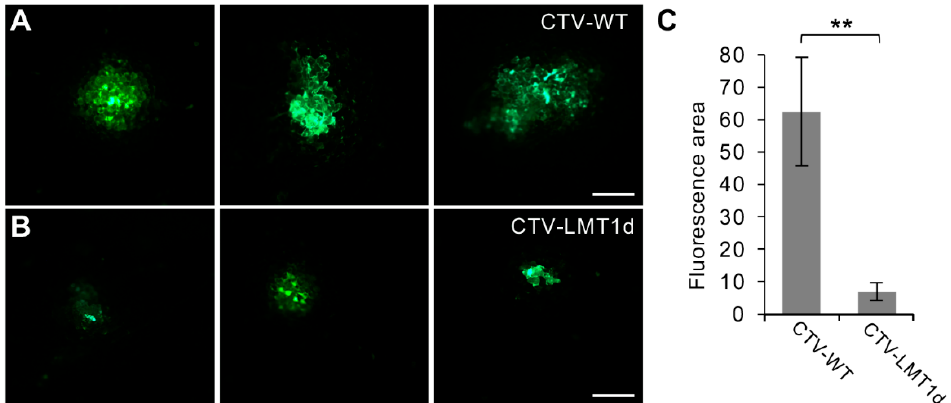
Figure 3. Assessment of CTV-WT ( A ) and CTV-LMT1d ( B ) cell-to-cell movement in the N. benthamiana leaves. Images show three representative GFP-expressing foci observed at 21 days after rub-inoculation of equal-concentration virion suspensions of CTV-WT or CTV-LMT1d in the mesophyll cells of N. benthamiana plants using fluorescence microscope. Bars = 0.1 mm. ( C ) Quantitative measurement of GFP fluorescence in the images shown in ( A ) and ( B ). Each bar represents a mean value +/- standard error of the mean calculated from all images of observed GFP foci ( n = 59 and 32 for CTV-WT and CTV-LMT1d, respectively). Statically significant differences determined by Student’s t-test, p < 0.01, were denoted by asterisk (**).